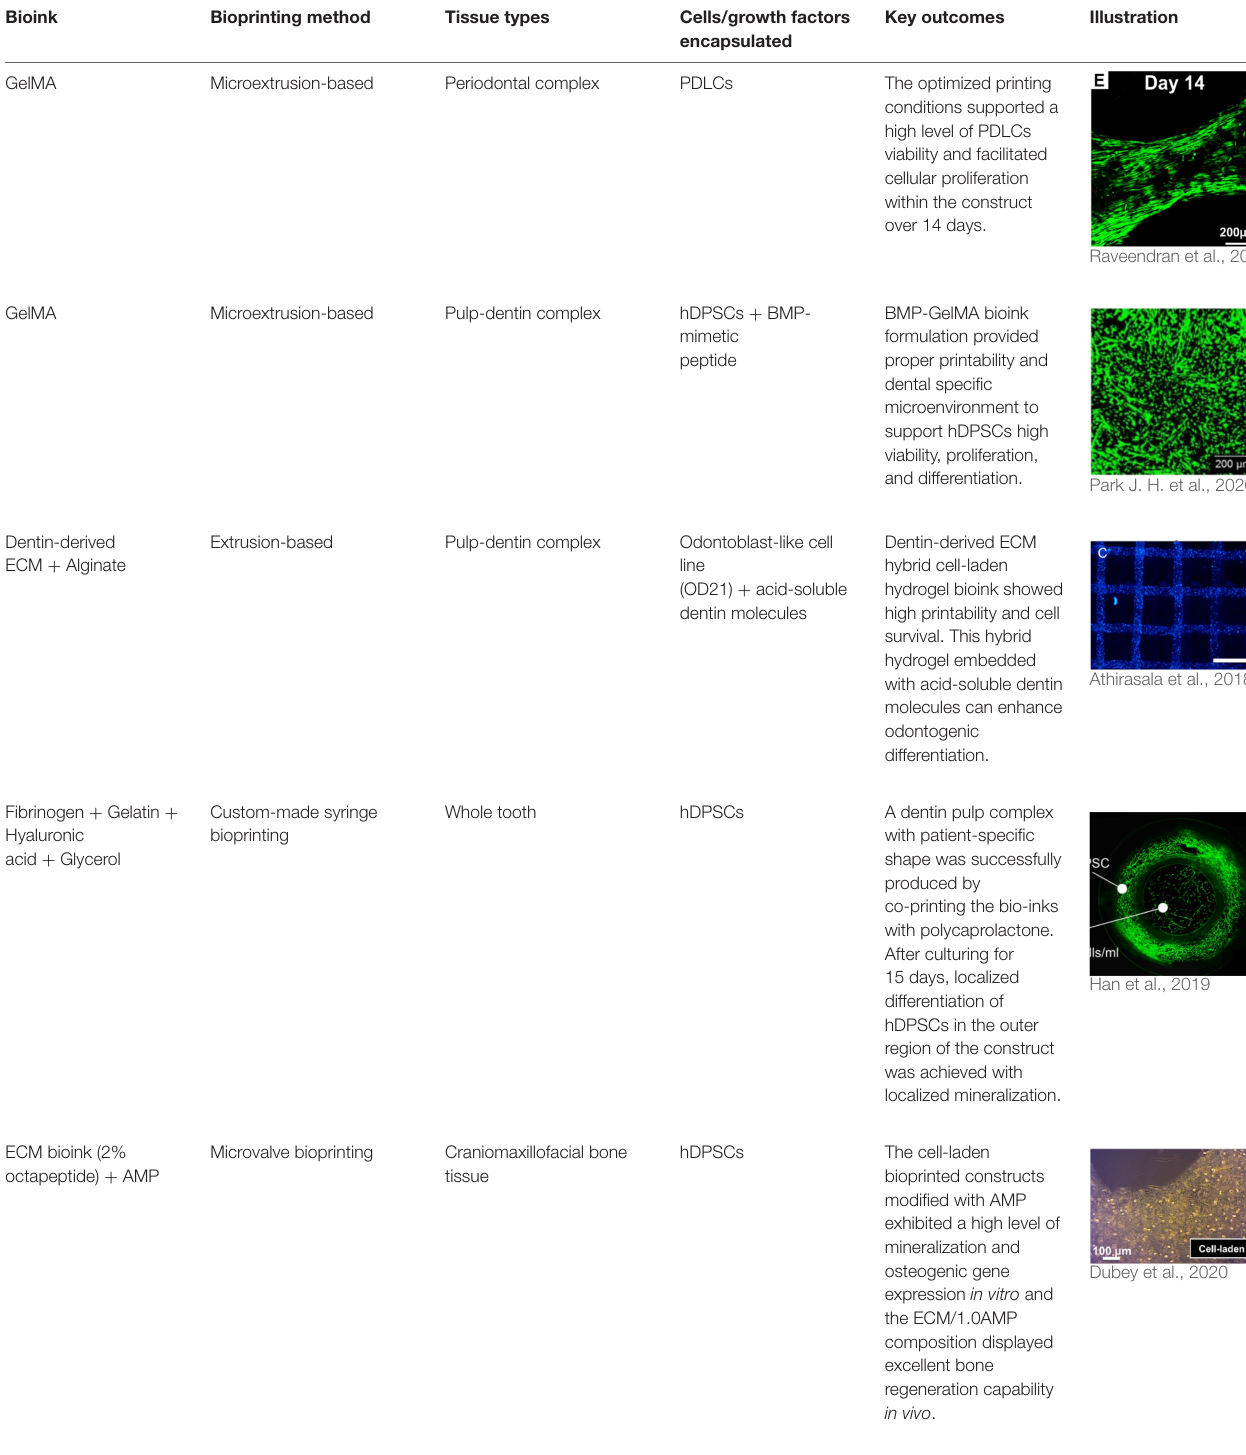
TABLE 3 | Representative studies on 3D bioprinting for dental, oral, and craniofacial-related regeneration from 2016 to